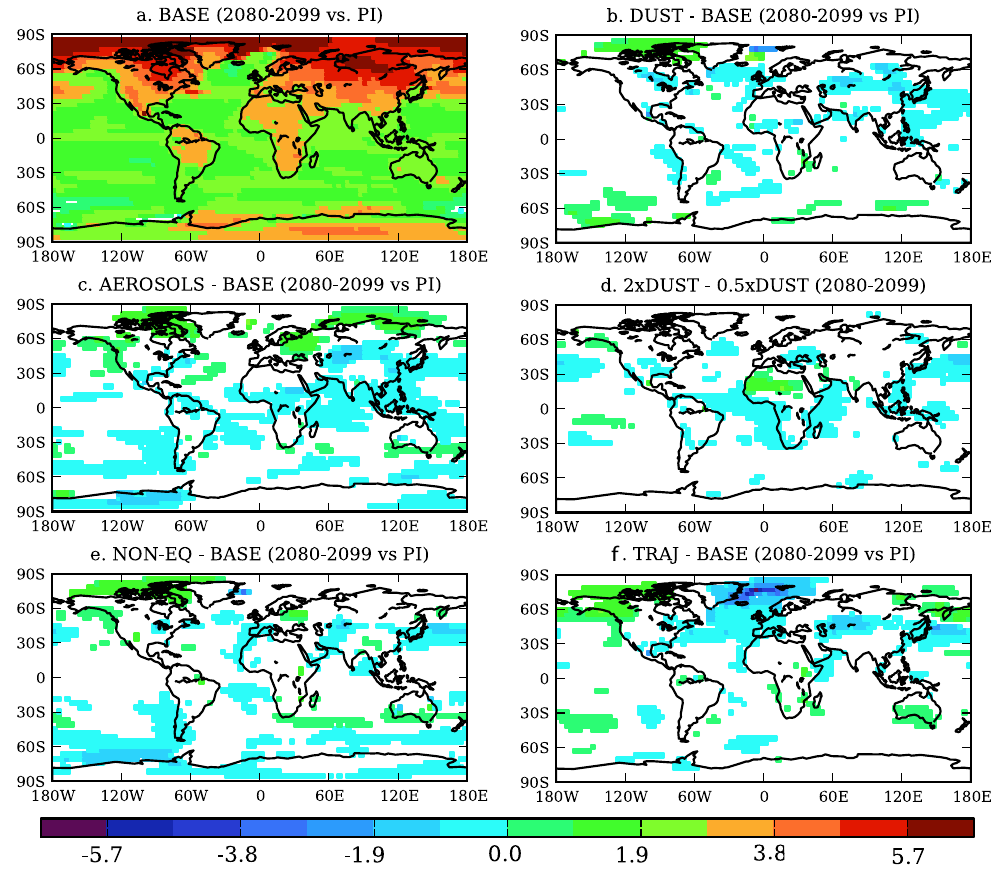
Fig. 8. Surface temperature (K) differences for 2080–2099 relative to the preindustrial control for each case: (a) mean change for 3 ensemble BASE case members, (b) differences from base case differences for interactive dust (DUST), (c) differences from BASE case for interactive aerosols (AEROSOL), (d) difference between 2xDUST and 0.5DUST cases, (e) differences from BASE case for case of NONEQ, and (f) differences from BASE for case of TRAJ. Only changes significant at the 95% level are shown in color. Notice that cases b, c, e and f are differences from the 3 BASE case differences from preindustrial (for example: (DUST2080-2099 minus DUST-control) minus (BASE2080- 2099 minus